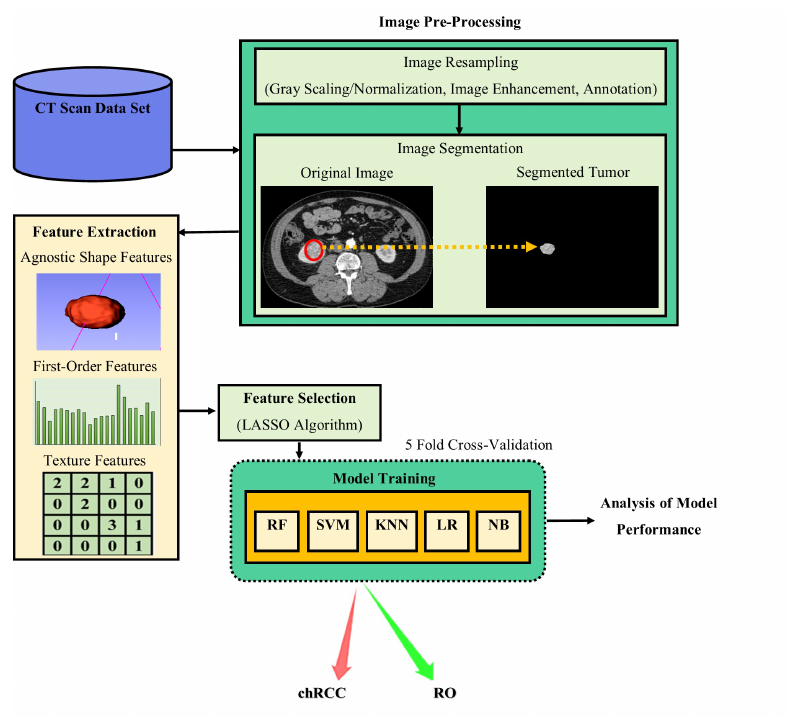
Figure 4. Represents the project methodology process developed by the